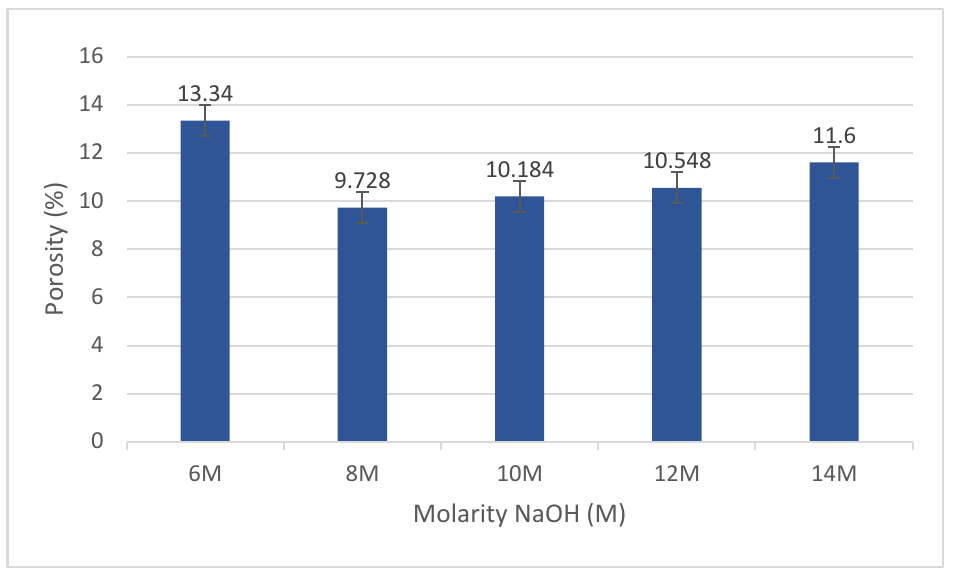
Figure 5. Porosity of fly ash/dolomite geopolymer.